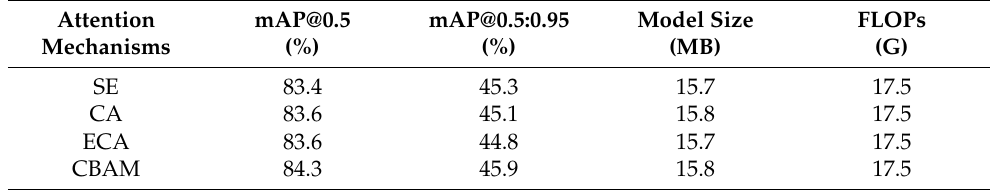
Table 5. Performance comparison of different attention